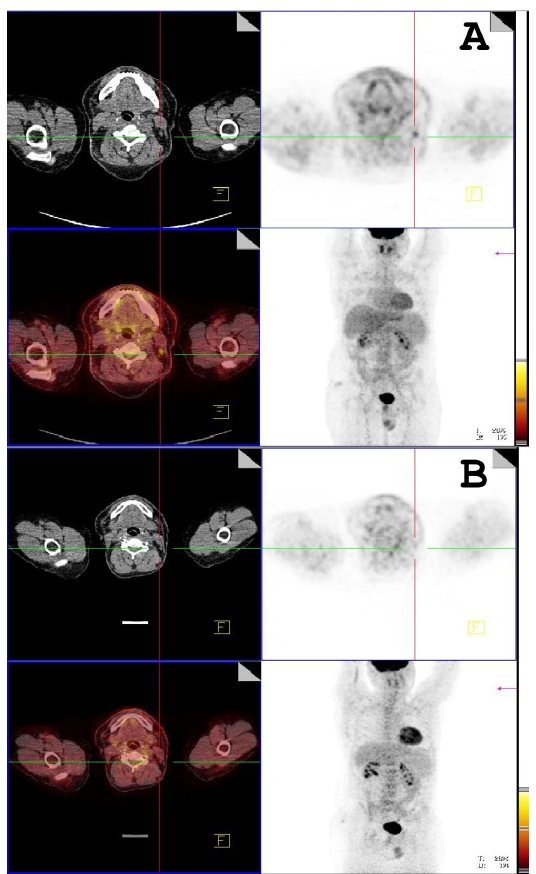
Figure 4. ( A ) First FDG PET/CT scan, active disease (sarcoidosis) present in the left cervical lymph node ( B ) Follow ‐ up FDG PET/CT scan, total remission of disease after therapy.